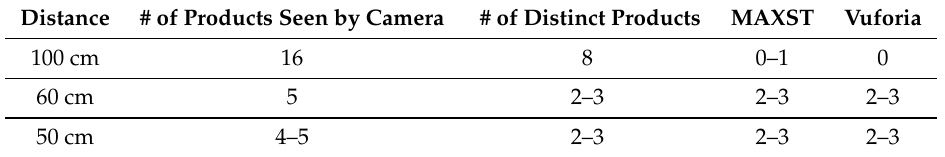
Table 4. The number of pouch-type products simultaneously recognized and tracked in the